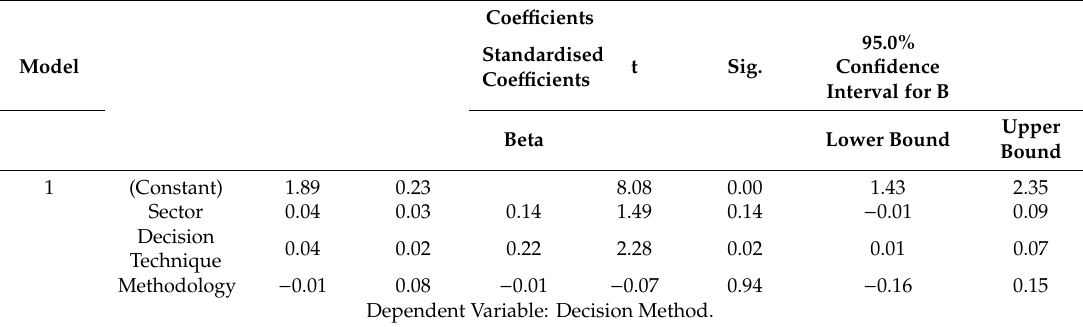
Table 3. A correlation analysis among key